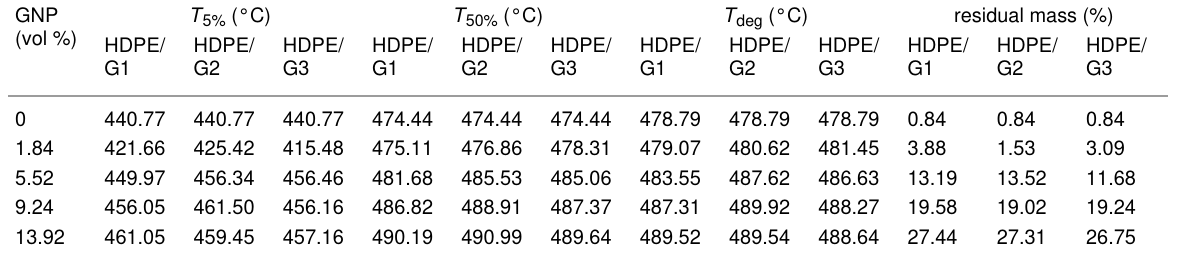
Table 3: Results of the TGA analysis of the HDPE/GnP nanocomposites. GNP (vol %)